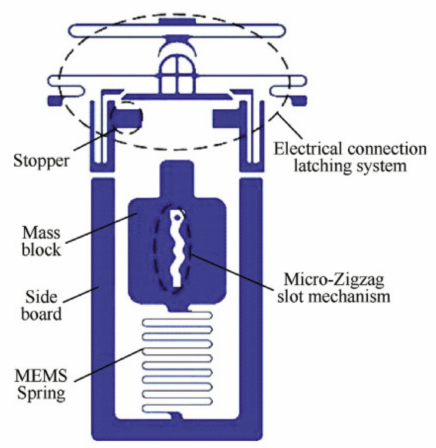
Figure 6. Schematic diagrams of the MEMS inertial high-g